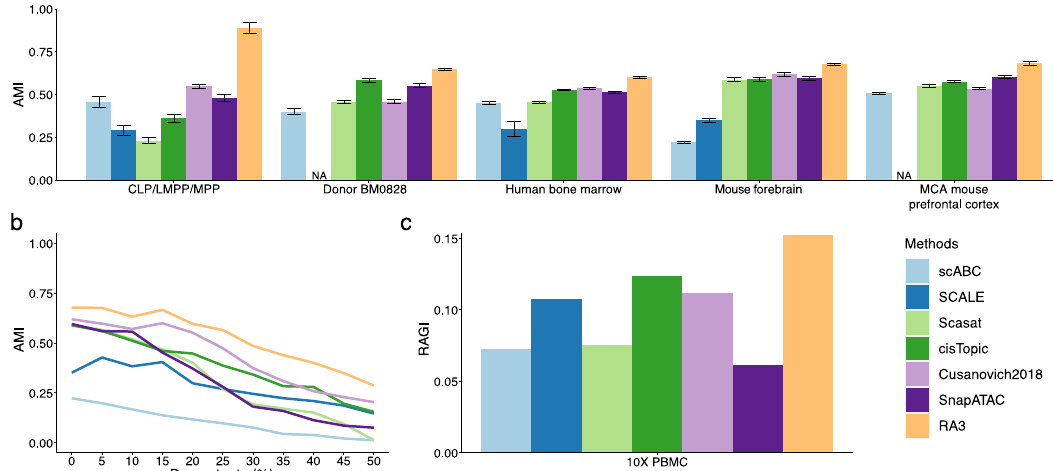
Fig. 4 Assessment of the clustering results. We implemented Louvain clustering on the low-dimensional representation provided by each method to get the cluster assignments. The cluster assignments for scABC were obtained directly from the model output. a The clustering performance using different methods evaluated by adjusted mutual information (AMI). The measure of center for the error bars denotes the AMI for different methods. The error bar denotes the estimated standard error in ten bootstrap samples. b The clustering performance using different methods on the mouse forebrain dataset (half) at different dropout rates evaluated by AMI. c The clustering performance using different methods on the 10X PBMC dataset evaluated by Residual Average Gini Index (RAGI)